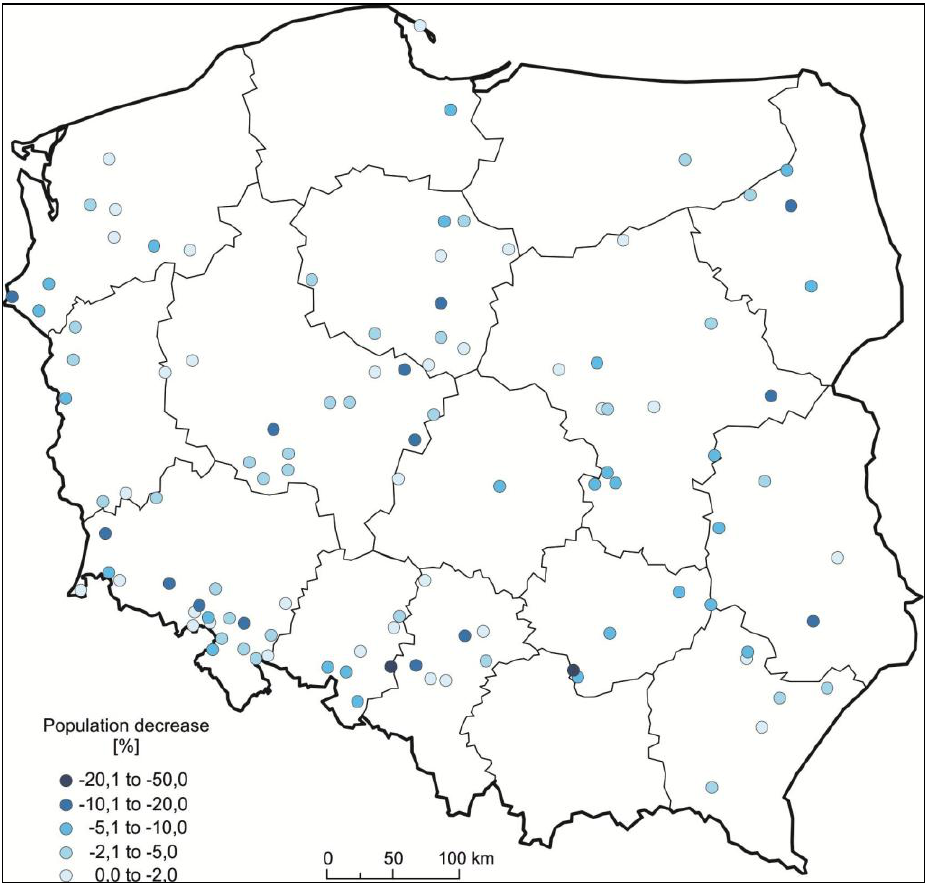
Fig. 4. Population decrease in towns of Poland, 1970-1980 (by author on the basis of Annex 2: Kantor-Pietraga,